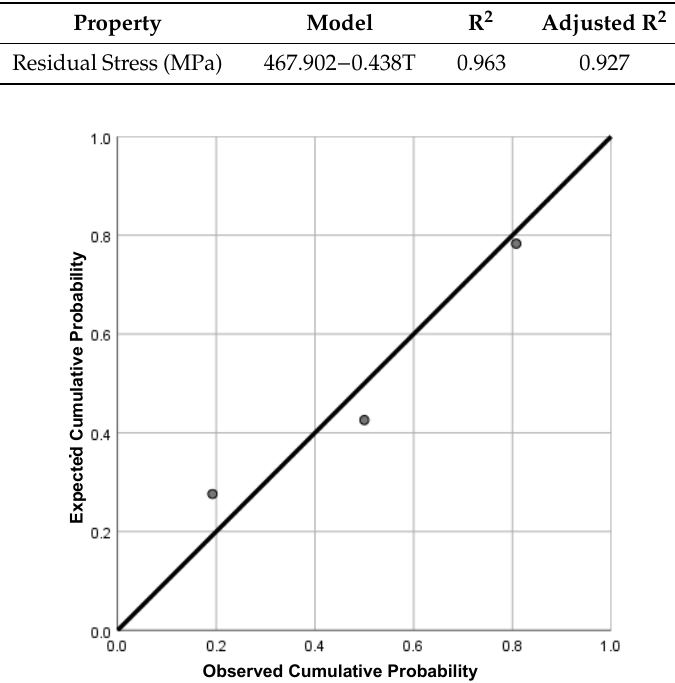
Table 26. Model for residual stress of ferritic stainless steel in terms of annealing temperature (T).